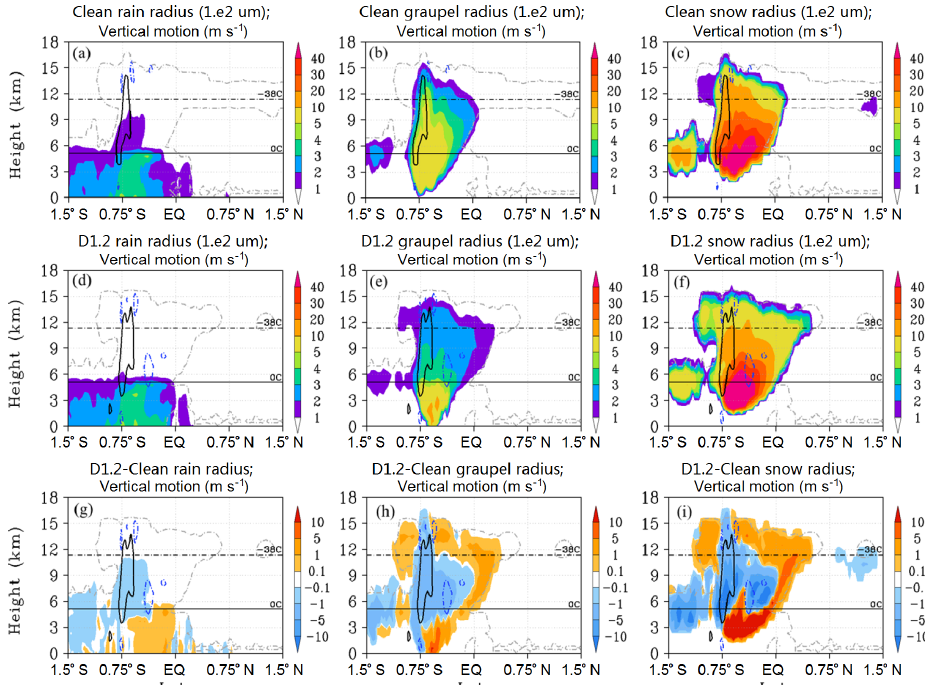
Figure 3. Slice plots representing same DCC as in Fig. 1 for Clean (row 1) and D1.2 (row 2) cases. Shaded colors: rain drop effective radii (Re; column 1), graupel Re (column 2), and snow Re (column 3); line contours, all columns: vertical motion (solid black >1ms − 1 ; dashed blue <, − 0 . 1ms − 1 ), cloudiness threshold (dashed grey, >1 × 10 − 6 kgkg − 1